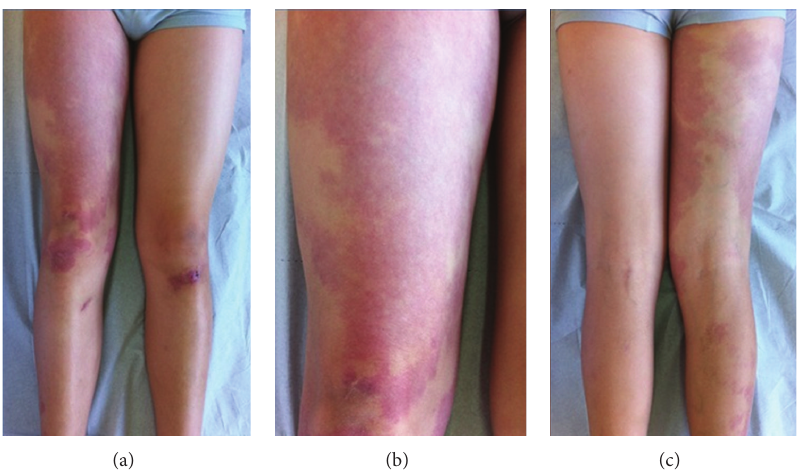
Figure 1: Multiple pink-red, irregularly shaped patches on the right lower limb (a)–(c).